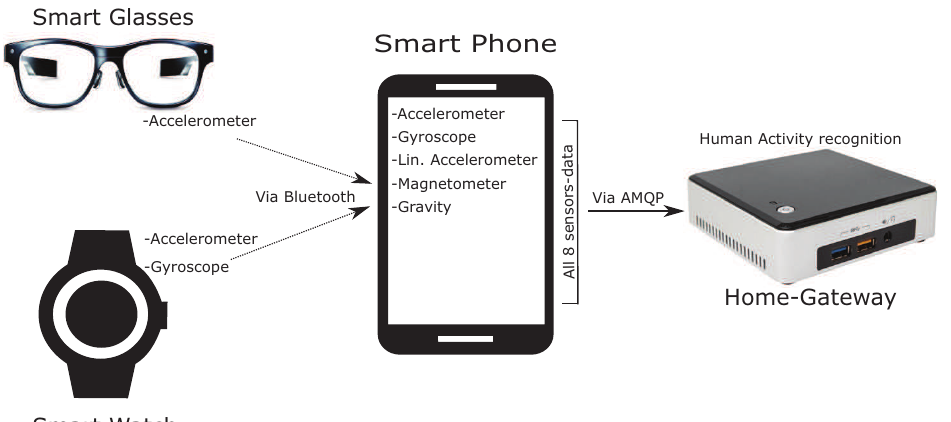
Figure 5. Activity recording setup using three wearable devices. The movement data of smart glasses Figure A1. System layout: Our system uses three wearable devices. The sensory data from the smart and watch is initially sent to smartphone via Bluetooth connection and later all the recorded data glasses and the smart watch are firstly sent to smart phone via Bluetooth connection and then all sent to a home-gateway using Wi-Fi connection [15]. sensory data is sent to home-gateway through Rabbit-MQ using Wi-Fi connection.